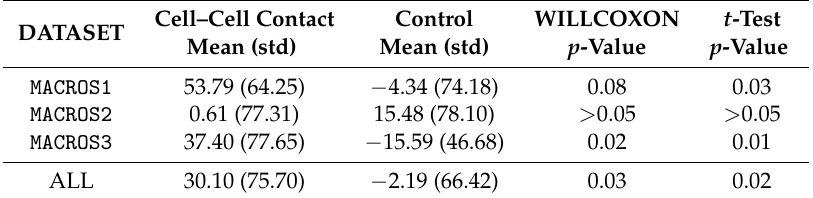
Table 3. Angle change ( θ x ) comparison per dataset. The mean and standard deviation angle change were calculated, and the results of the statistical tests comparing both contact and control experiments are shown. In moments where the null hypothesis could not be rejected are highlighted in red.